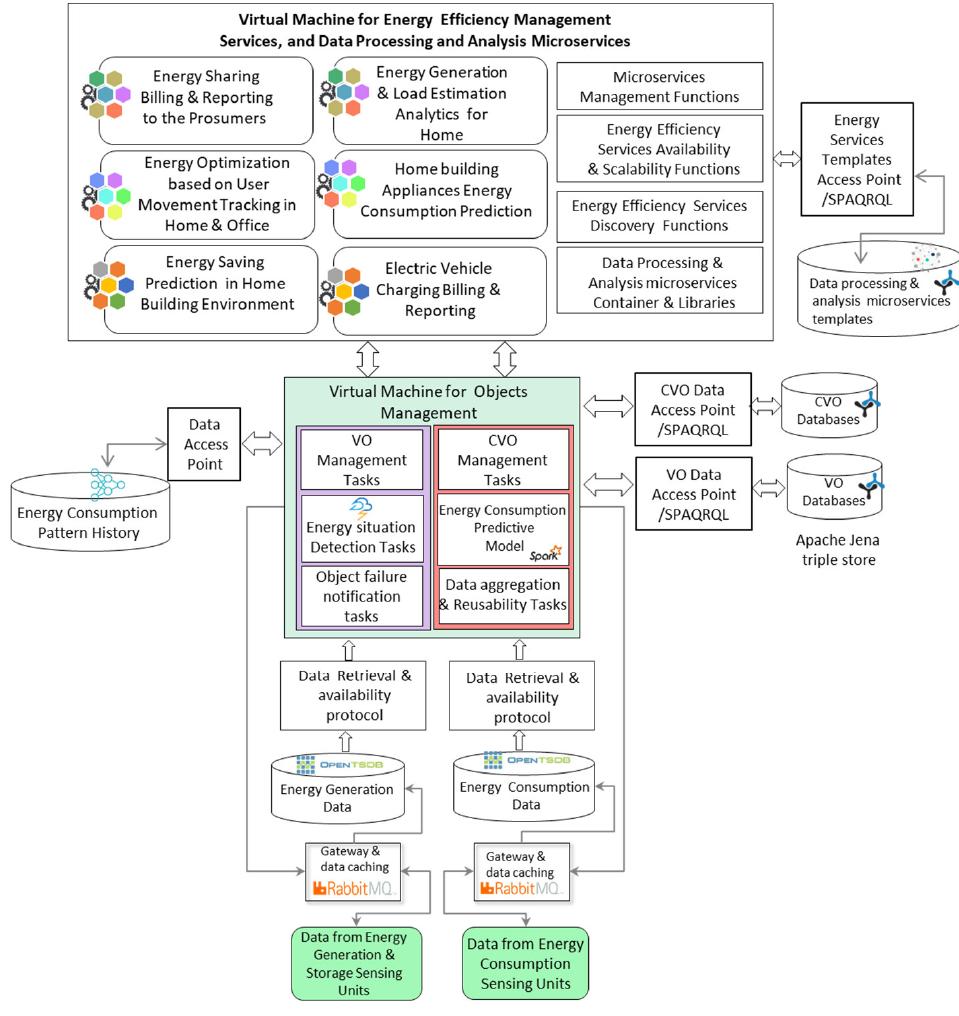
Figure 9. A prototype model for the use case scenario.